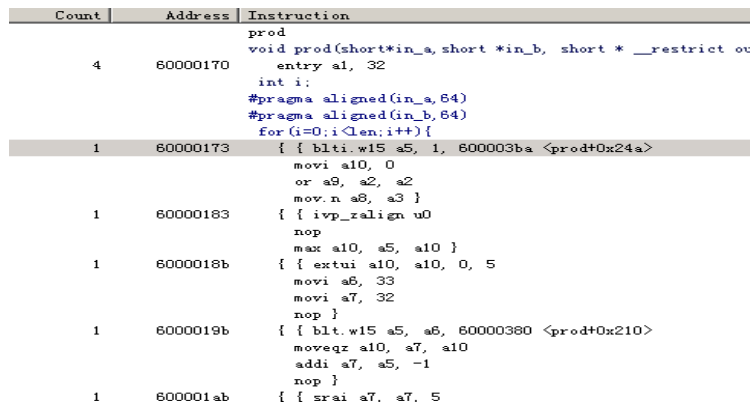
Figure 8. Cycle count statistics of dot product of two one-dimensional vectors with vectorization.